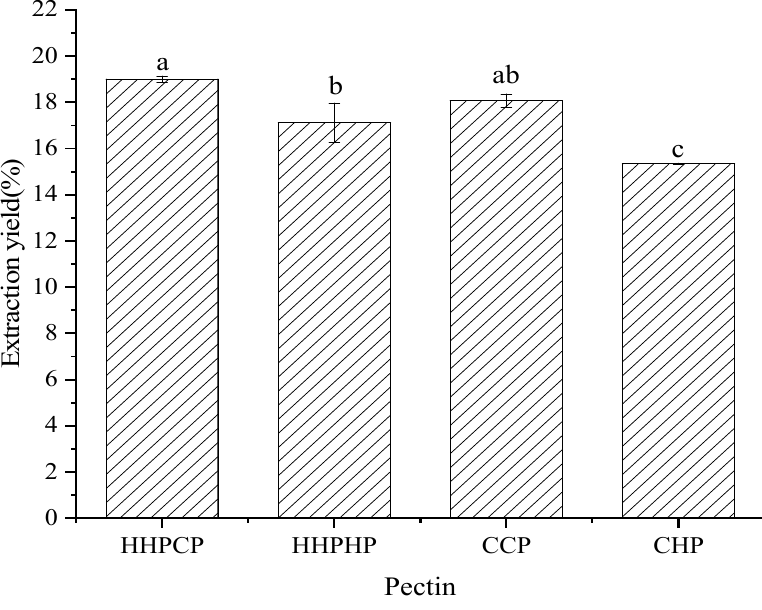
Figure 1. Effect of different extraction methods on extraction yields of Satsuma mandarin peel pectin. Note: different letters (a–c) denote significantly different in the row ( p < 0.05).